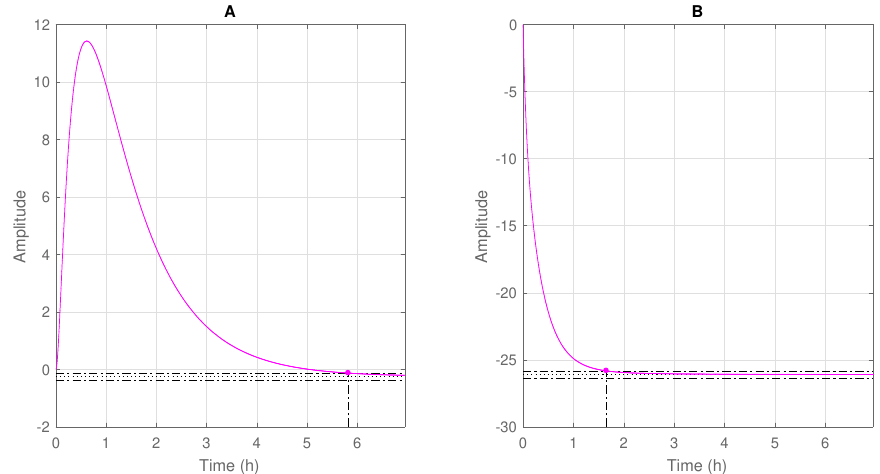
Figure 5. Step response profiles of w po after changing the ( A ) gas lift injection ( w gc ); and ( B ) production choke opening ( u 2 ).